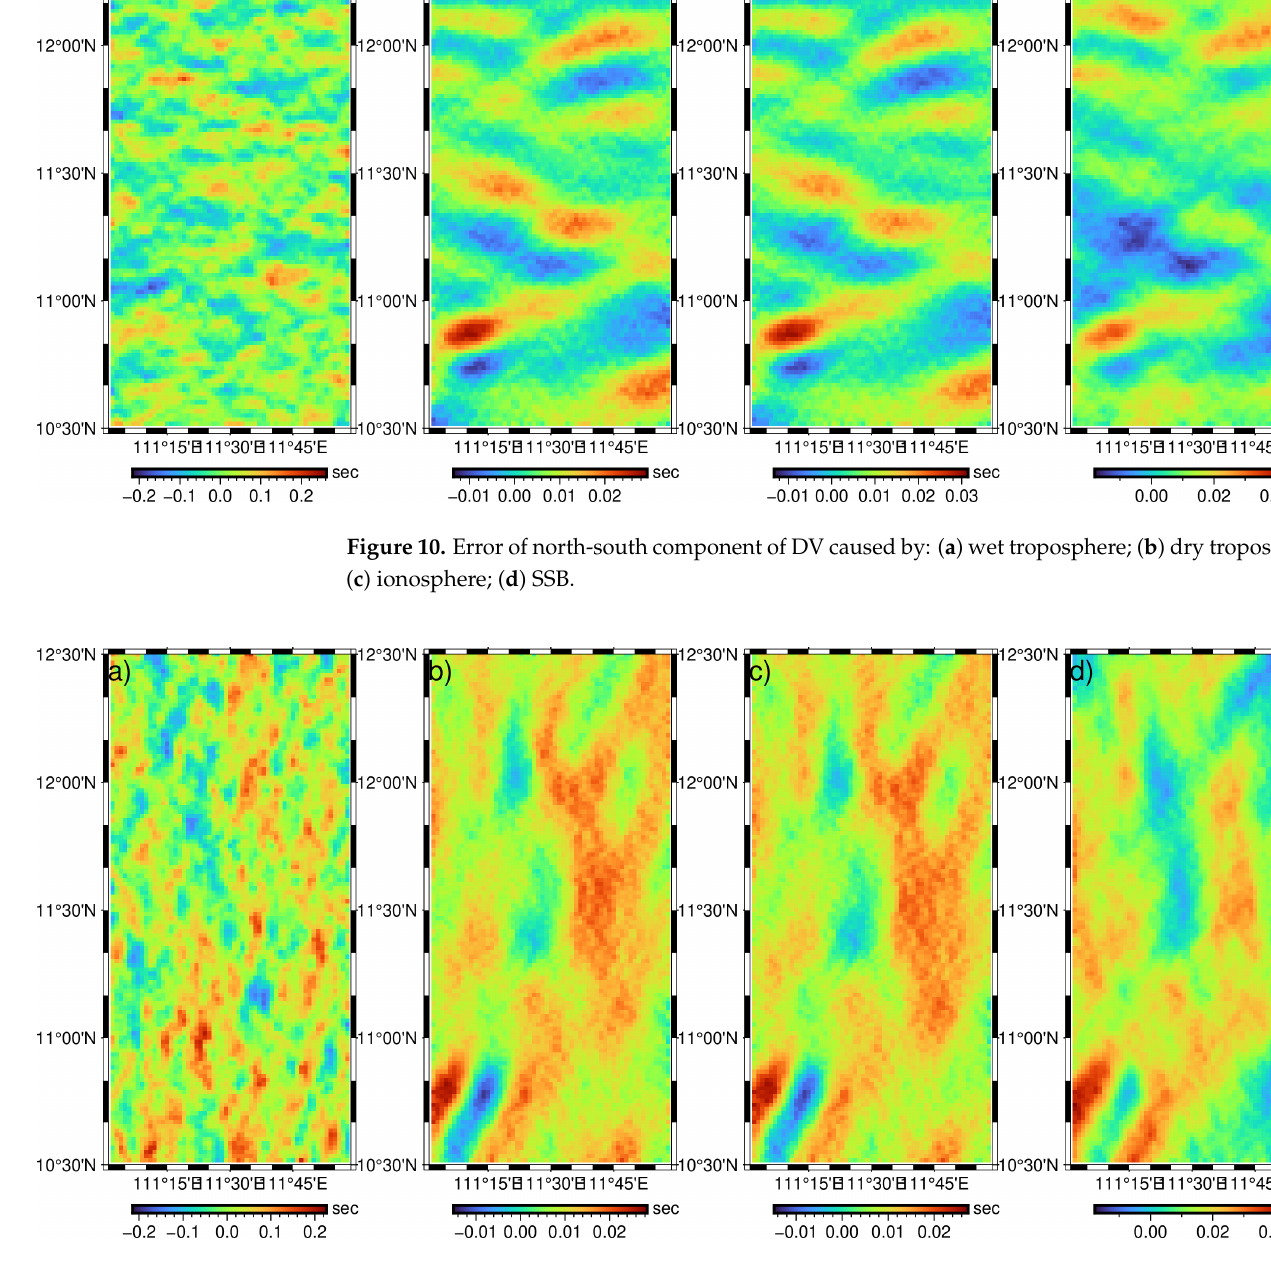
Figure 11. Error of east-west component of DV caused by: ( a ) wet troposphere; ( b ) dry troposphere; ( c ) ionosphere; ( d ) SSB. Table 3. The Influence of residual environmental errors on the recovery accuracy of DV (uint: arcsec).